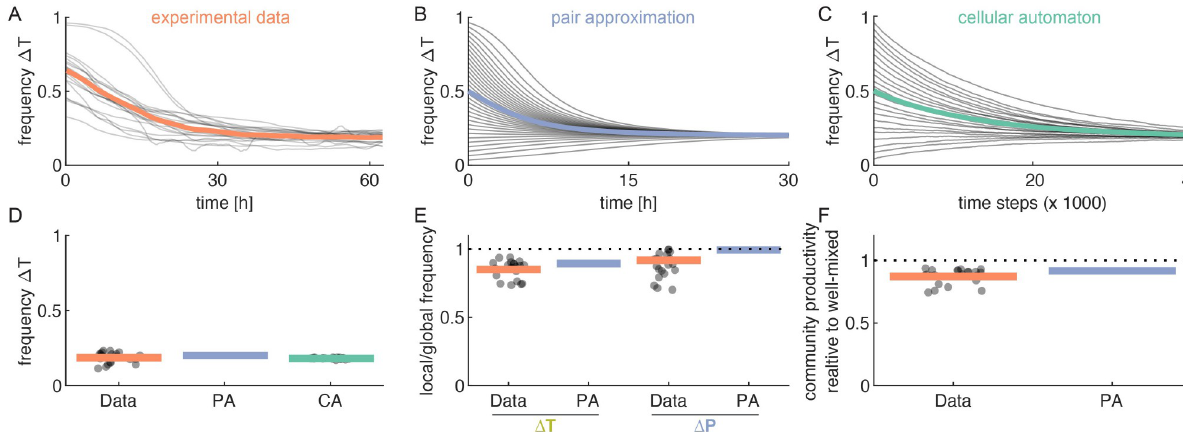
Fig 6. Our mathematical framework can explain experimentally observed community properties. The model parameters for the experimental community were calculated from the biophysical model (S2 Table). (A) Experimental communities approach a stable frequency of Δ T . Individual communities (thin lines, n = 22) and their average value (thick line) are shown. The initial frequency of Δ T in the communities is determined by the initial number of cells that enter the microfluidic growth chambers and the subsequent growth before the start of image acquisition; as a result, it cannot be controlled experimentally. (B) Pair approximation predicts a unique stable equilibrium. The dynamical equations (Equations 12–14 in S2 Text) were solved numerically starting from different initial frequencies. (C) Cellular automaton simulations also reach a unique stable equilibrium. (D) The observed equilibrium frequency of Δ T is consistent with the model predictions. Data: P ( A ) = 0.19 (95% confidence interval (CI): 0.17–0.20), Pair- approximation: P ( A ) = 0.20, and cellular automaton: P ( A ) = 0.18 (CI: 0.18–0.19, evaluated after 100’000 time steps). The difference between the model prediction and data is less than 8%. (E) The frequency of the partner cell type within the interaction neighborhood (local frequency) is lower that the global frequency because cells are surrounded by their own offspring. Dots show measurements for 21 replicate communities, bar shows mean value. Pair approximation predicts (Eq 3) a decrease in frequency of 0.99 for Δ P and 0.89 for Δ T , the experimental values are 0.92 (CI: 0.84–0.99) and 0.85 (CI: 0.82–0.88), respectively. The difference between the model prediction and data is less than 13%. (F) The average growth rate of the community is reduced due to cell clustering. An in-silico analysis (see Methods) shows that the growth rate in clustered communities, with experimentally observed spatial arrangements, is reduced by a factor of 0.87 (CI: 0.85–0.90) compared to randomized communities, where cell clusters were disrupted (Data reproduced from [11]). Pair approximation predicts a decrease by a factor of 0.92 (S3 Table); the difference between the model prediction and data is less than